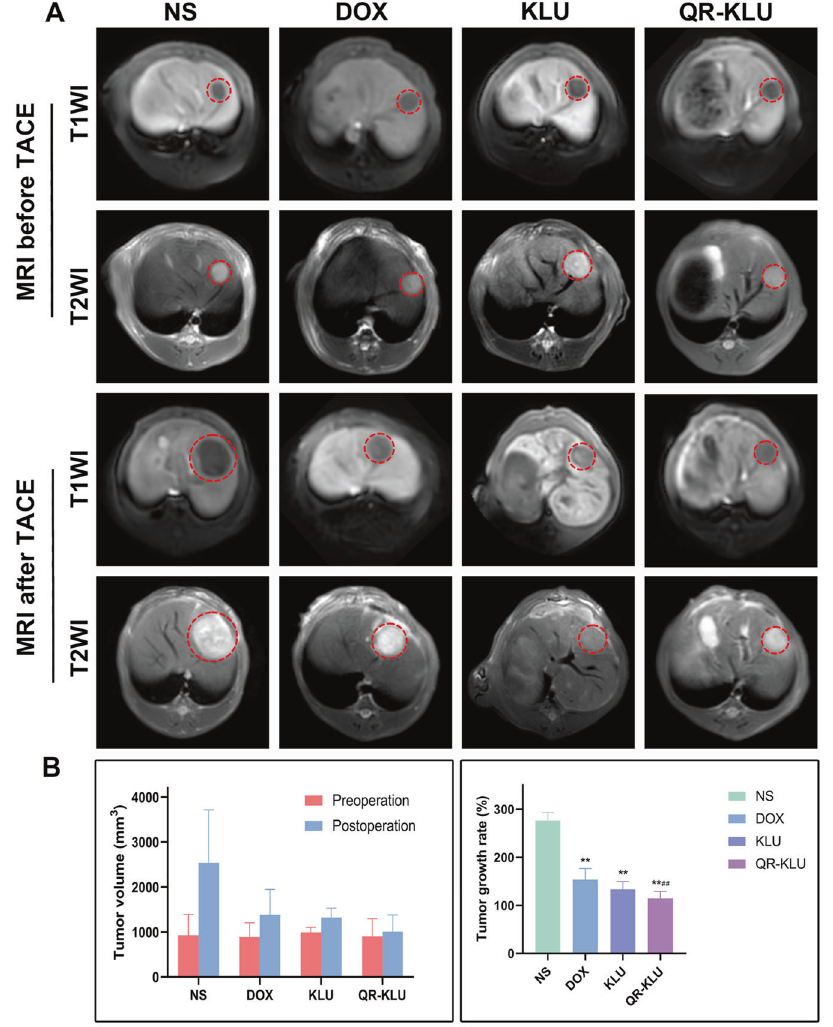
NS, DOX, KLU and QR-KLU groups. ** P < 0.01 versus NS group, ## P < 0.01 versus DOX